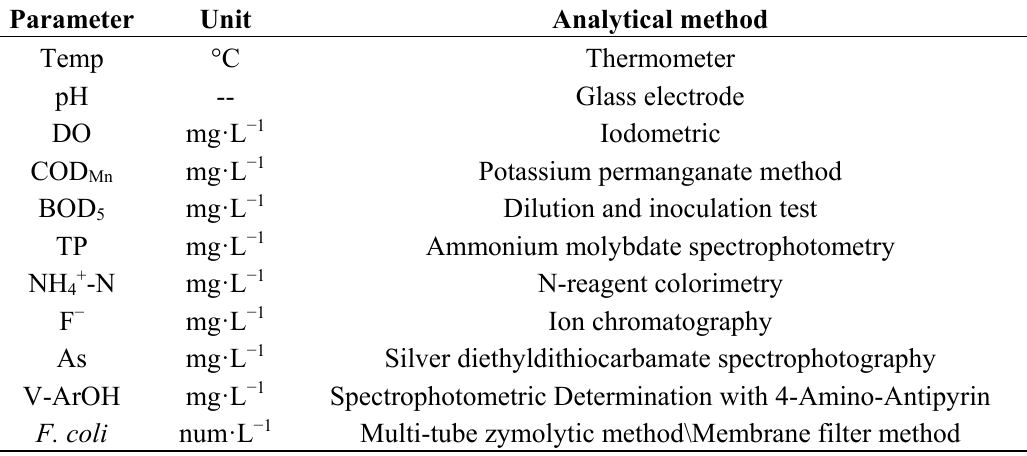
Table 1. Water quality parameters, units and analytical methods used during 2012–2014 for the Danjiangkou Reservoir Basin.